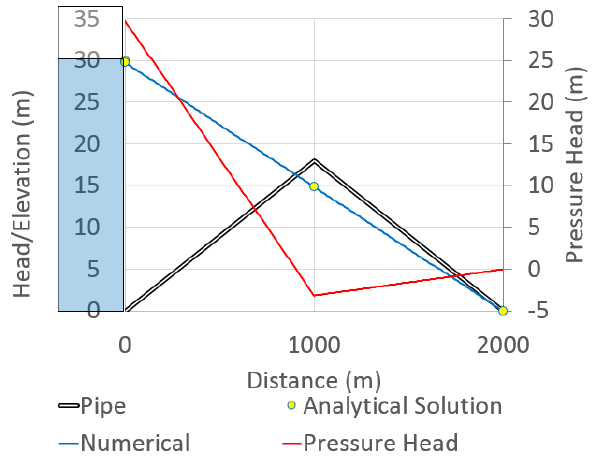
Figure 13. Established steady state hydraulic grade line (HGL) at the flow rate of 0.1712 m 3 /s.